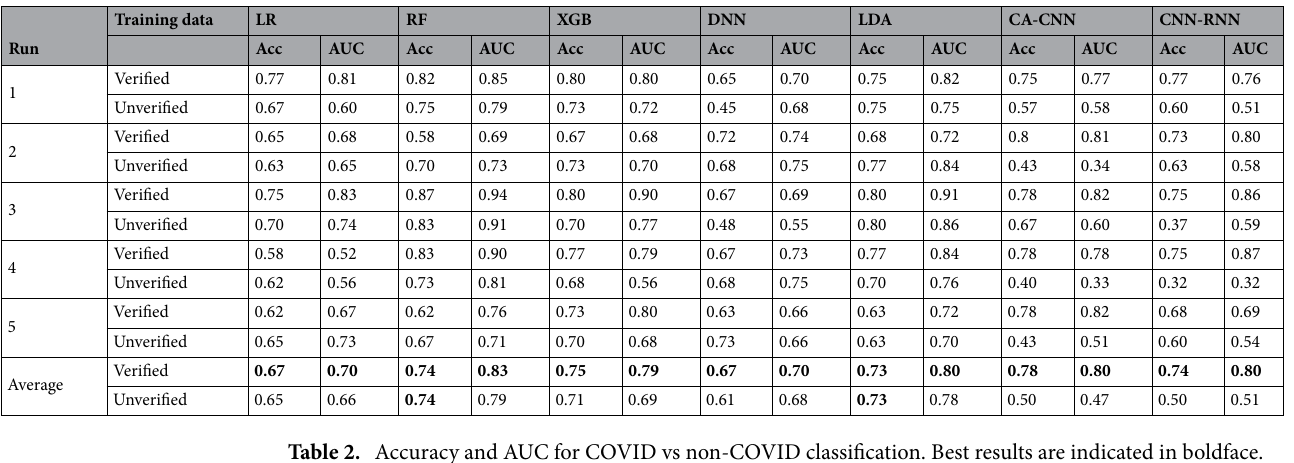
Table 2. Accuracy and AUC for COVID vs non-COVID classification. Best results are indicated in boldface.